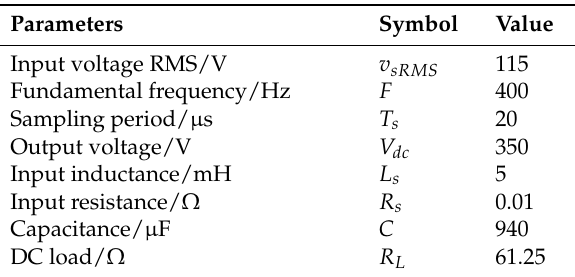
Table 1. Digital simulation